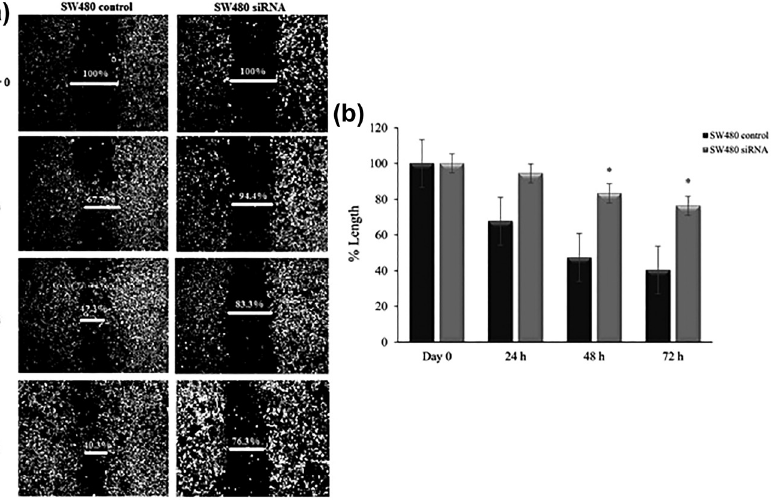
Figure 4: The migration of clusterin-silenced SW480. (A)Themigrationrateinnon-clusterin-silenced(control)andclusterin-silencedSW480(siRNA)at24,48,and72hofincubation.Cellmigration